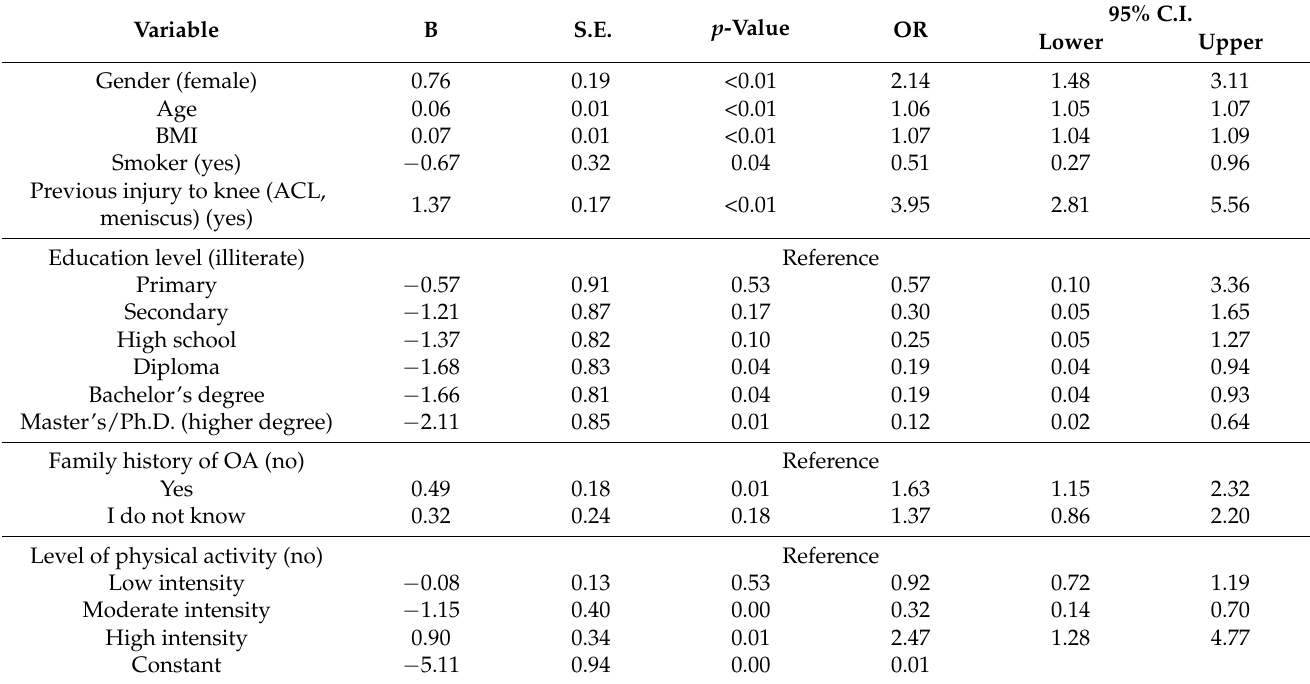
Table 4. Binomial logistic regression results for knee OA with the different study